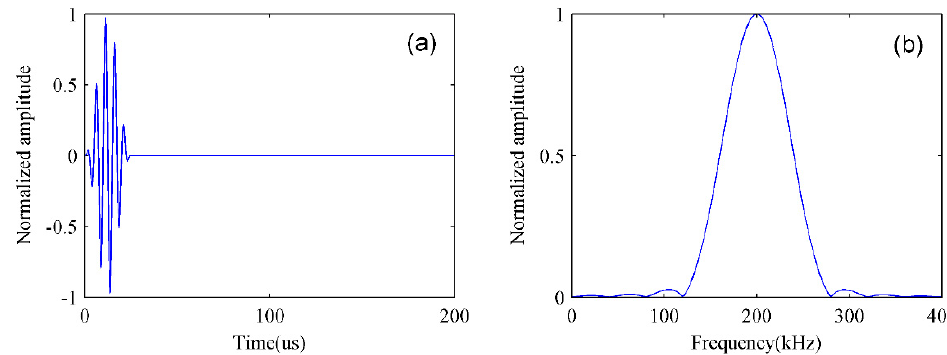
Figure 4. Finite element model.